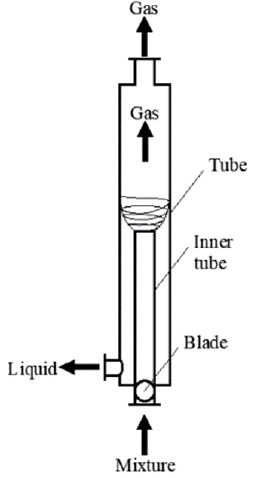
Figure 1. Separator separation schematic .